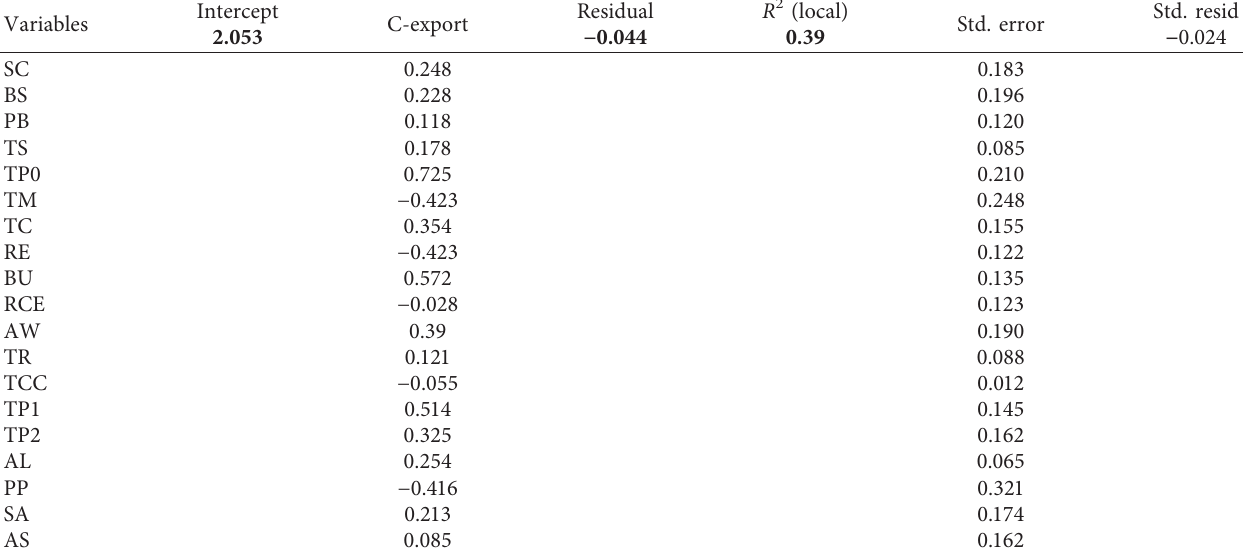
Table 5: Summary results of the GWR model for predicting crashes.